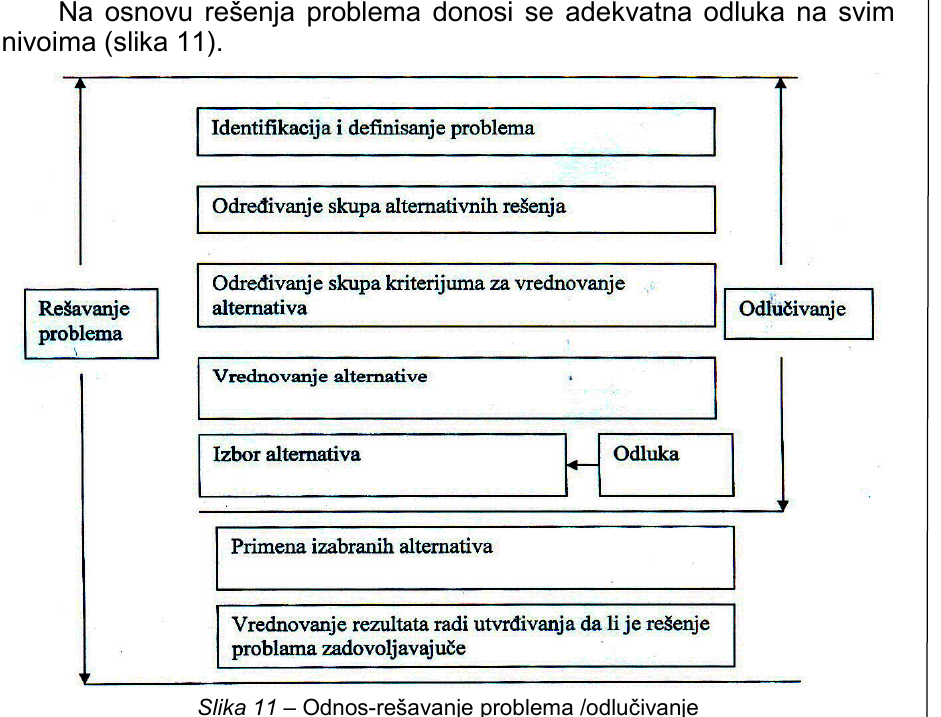
Figure 11 – Relation-problem solving / decision